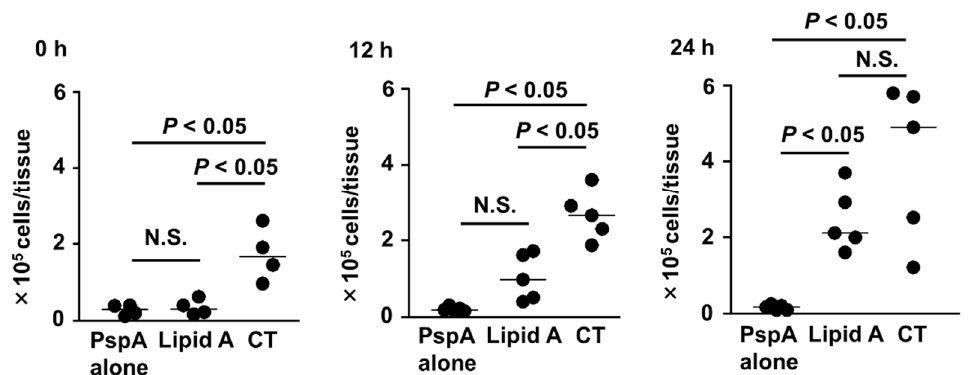
Figure 7. Infection-induced increase in neutrophil counts in the nose of mice nasally immunized with PspA plus Alcaligenes lipid A. Before or after S. pneumoniae infection (at 0 h, 12 and 24 h), cells were collected from the nasal mucosa for measurement of neutrophils. Data are representative of two independent experiments (uninfected, n = 4 per group; infected, n = 5 per group). The horizontal line indicates the median. Statistical significance was evaluated by using one-way ANOVA at p < 0.05; N.S., not statistically significant.